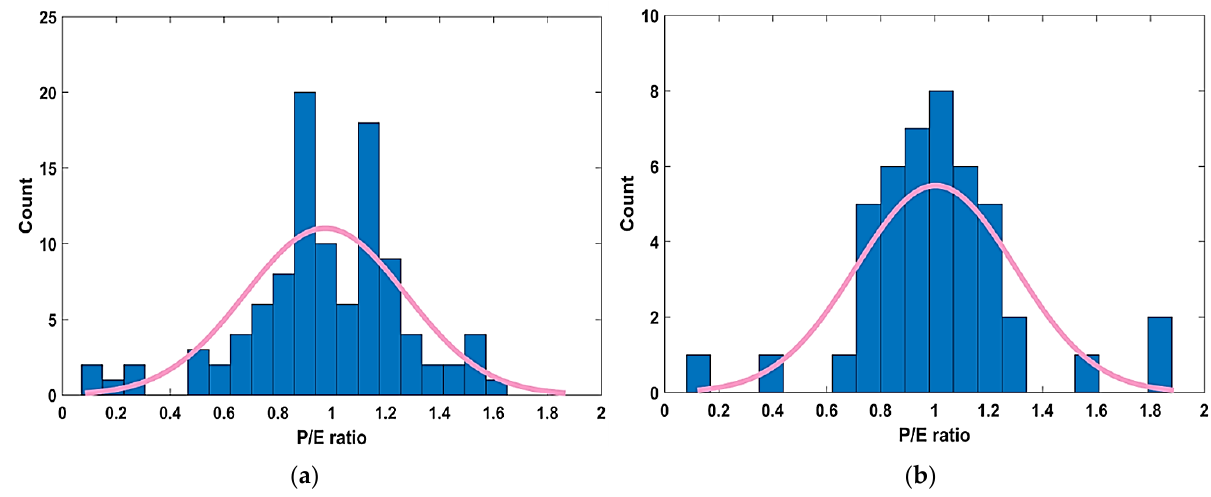
Figure 7. P/E ratio distribution of the best performing model T3, ( a ) TR phase, ( b ) TS